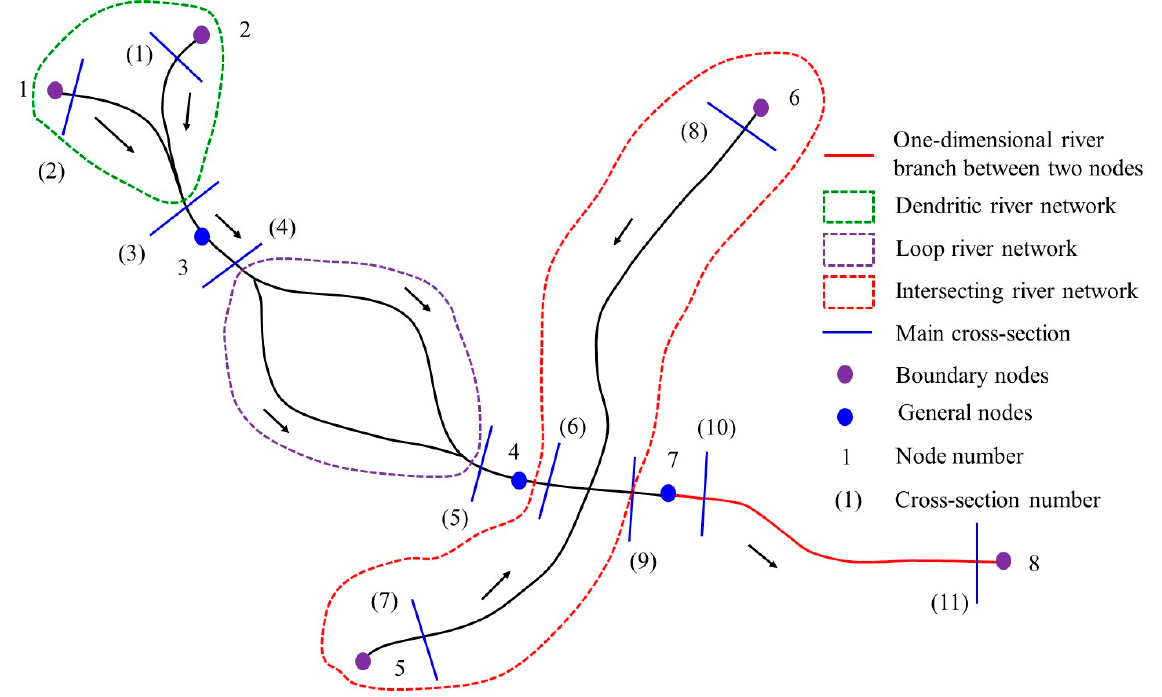
Figure 1. Different river network types and components in DF-RMS.